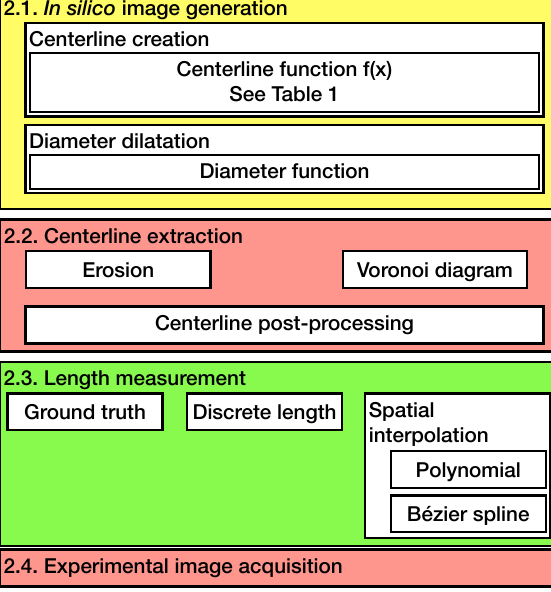
Figure 1. An overview of the methods used in this paper. Sections 2.1–2.3 deal with the in silico method and Section 2.4 with the experimental